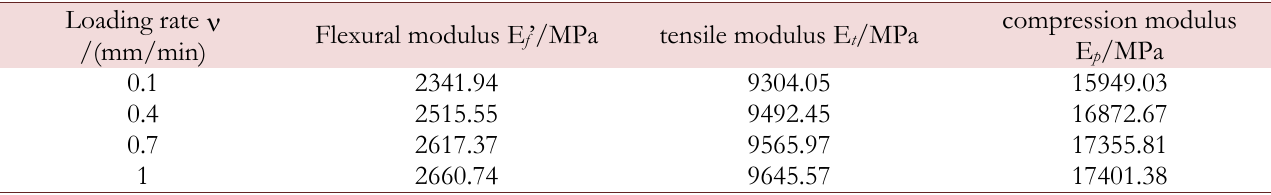
Table 2: Tensile, Compression and Flexural Modulus Test Results under Different Loading Rates.